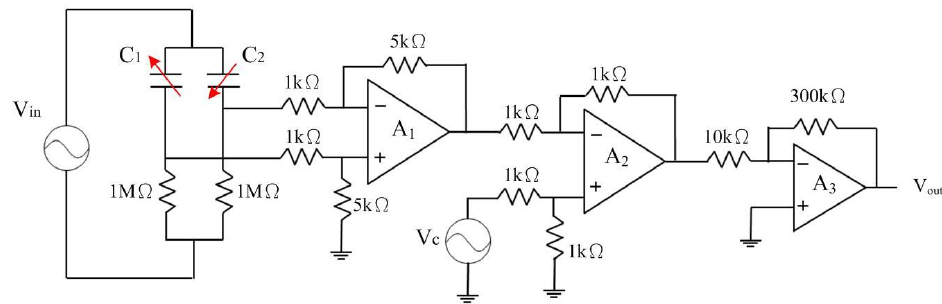
Figure 6. Sensing circuit for the magnetic sensor.